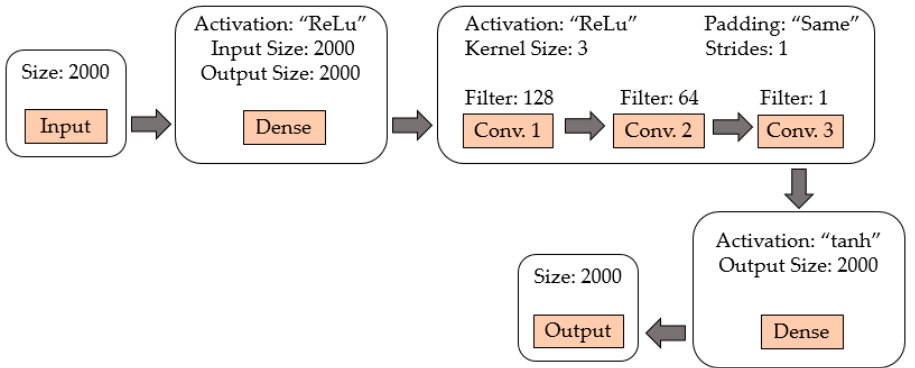
Figure 5. Architecture of the generator model.